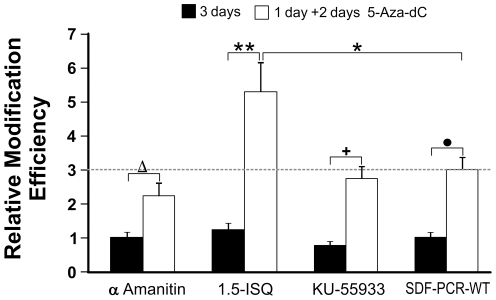
Relative modification efficiency in D1 cells transfected with SDF-PCR-WT and treated with α-Amanitin, 1,5-Isoquinolinediol and KU-55933.Transfected samples were analyzed three days after transfection (3 days; black columns) or in parallel treated 24 hours after transfection with 0.5 µM of 5-Aza-dC for 48 hours (1 day+2 days 5-Aza-dC; white columns). No statistically significant differences were observed at 3 days (black bars) respect to untreated cells (SDF-PCR-WT). Demethylating effect of 5-Aza-dC increased eGFP detection in all samples (white columns) in a statistically significant manner (Δ p = 0.003; +p = 0.01; • p = 0.0007). 5-Aza-dC addition also disclosed the effect of 1,5-Isoquinolinediol on SDF-mediated correction in a statically significant manner respect either to cells not treated with 5-Aza-dC (**p = 0.0002) and to the cells transfected with SDF-PCR-WT in which no drug was added (*p = 0.003). Dashed lines refers to modification efficiency observed in cells without addition of any drug but treated by 5-Aza-dC. Results are from mean values of three independent experiments and are reported as relative modification efficiencies in respect to control without drugs (SDF-PCR-WT).